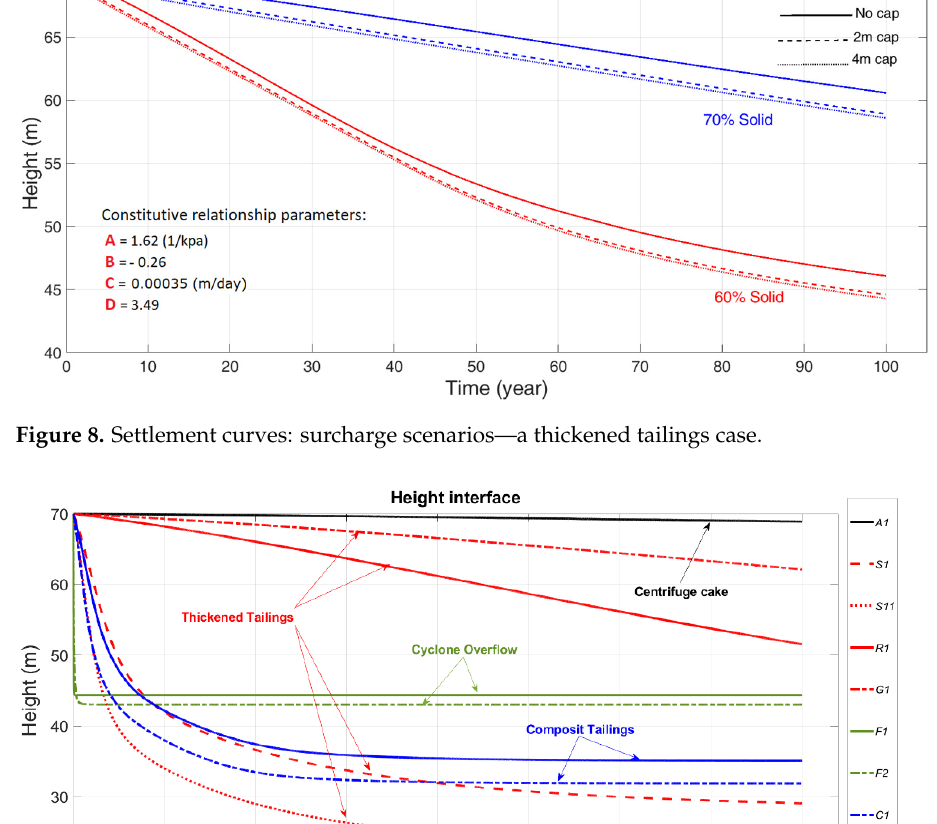
Figure 7. Settlement curves: solids contents and specific gravity scenarios—a thickened tailings case.